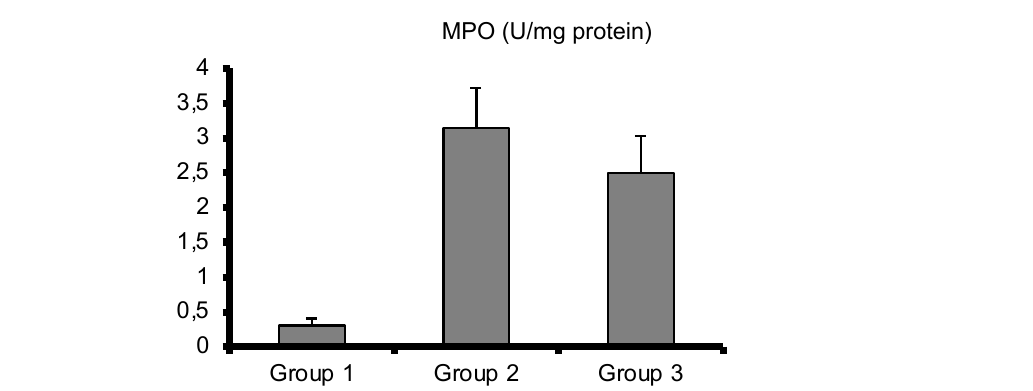
FIGURE 1 - The level of MPO in groups. a : p<0.05 compared to group 1 (control group). TABLE I - T he levels of oxidative/nitrosative stress biomarkers in groups